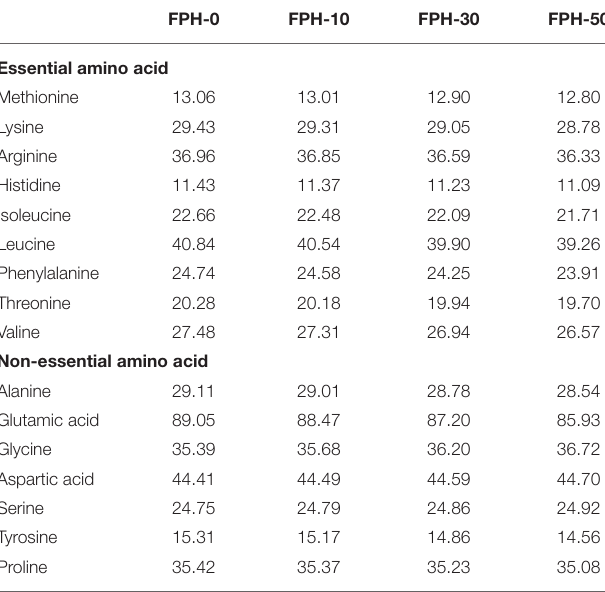
TABLE 2 | Amino acid composition of experimental diets (g kg − 1 dry